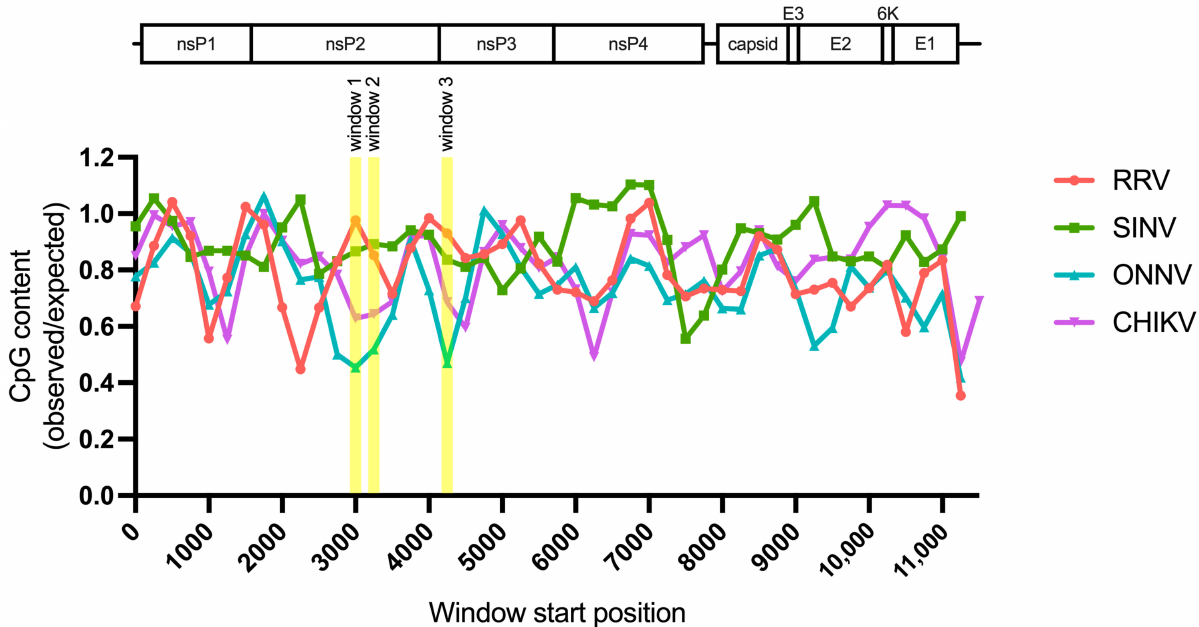
Figure 6. Sliding window analysis of alphavirus CpG content. The ratio of observed CpG dinu- cleotide frequency to expected frequency based on mononucleotide content (observed/expected) was calculated across alphavirus genomes using a window size of 500-bp and a step size of 250-bp. The genomes were aligned from the start of their 5 (cid:48) untranslated regions. Windows with CpG contents that correlate with alphavirus replication sensitivity to ZAP are annotated (windows